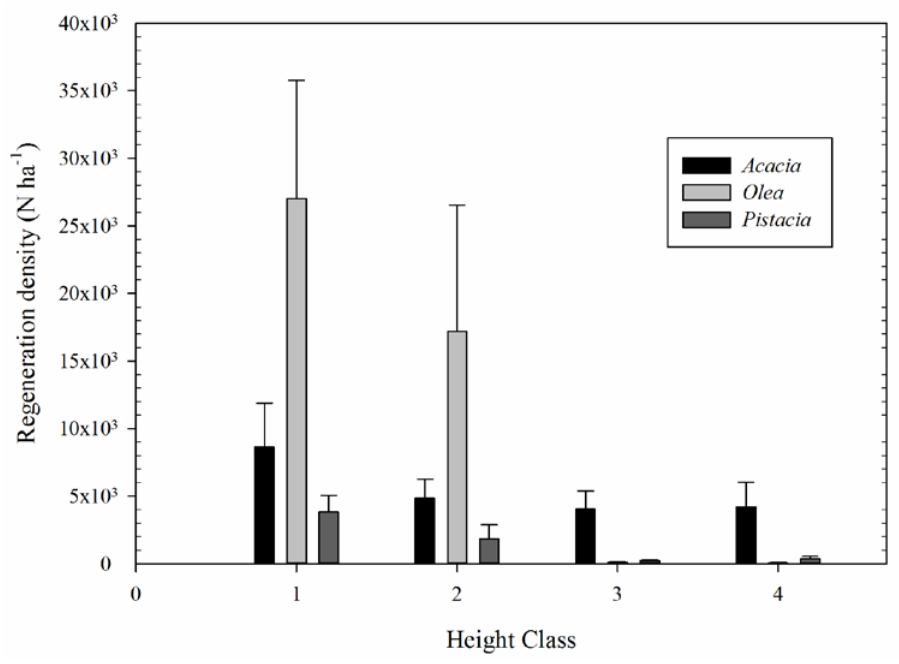
Figure 4. Height class distribution of the woody species regeneration in the understory.